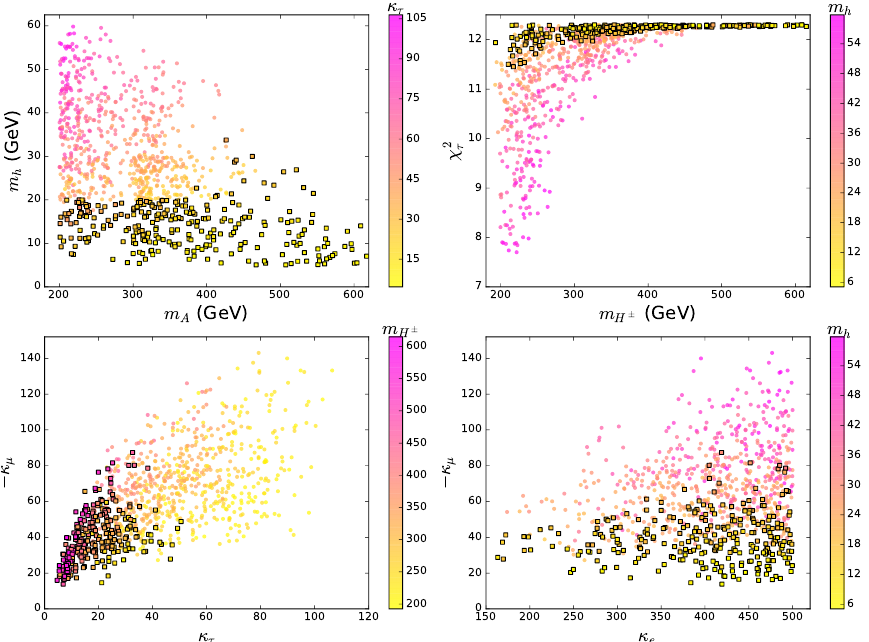
Figure 6. Allowed regions in the parameter space of the model discussed in [30], taken from that reference, where squares denote allowed and bullets excluded regions in the models parameter space.